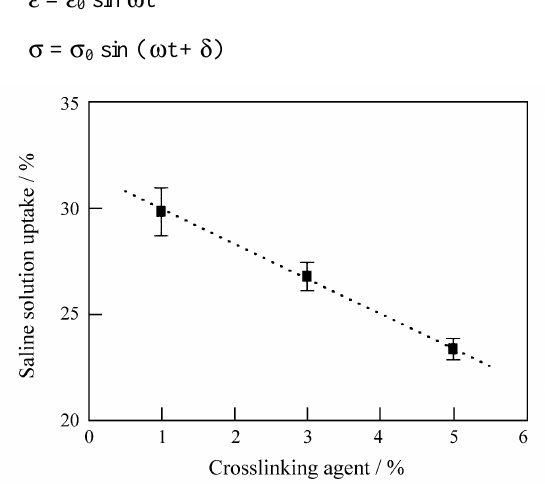
Figure 4. Saline solution uptake of polyHEMA with different crosslink- ing agent content.